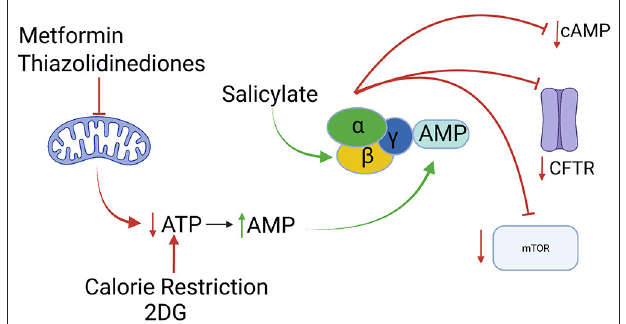
FIGURE 1 | Activation of the AMPK enzyme, depicted as a heterotrimer of α , β and γ subunits, can result in inhibition of of the mTOR pathway, of CFTR-mediated fluid secretion and of cAMP accumulation. AMPK activity can be stimulated indirectly by interventions that reduce ATP production [metformin, thiazolidinediones, 2-deoxy-D-glucose (2DG), calorie restriction] or directly (salicylate). All of interventions slow disease progression in animal models of ADPKD. Created with